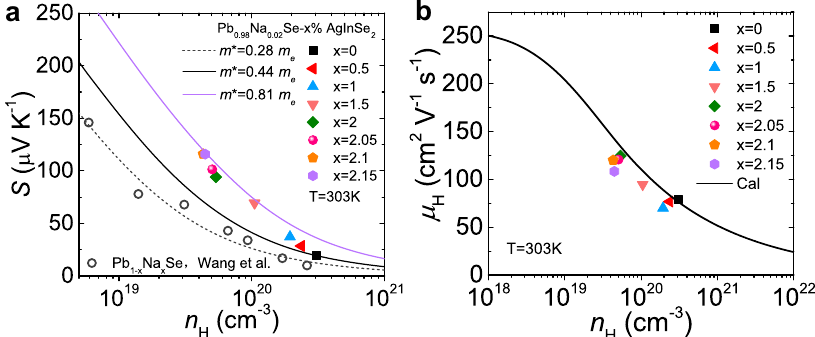
Fig. 4 Pisarenko plot and Hall carrier mobility. a Pisarenko plot of Seebeck coef fi cients as a function of Hall carrier concentration ( n H ) for Pb 0.98 Na 0.02 Se − x % AgInSe m * = 0.44 m m * = 0.81 m 2 (LISS). The solid black line is calculated assuming e and the purple line represents the result assuming e within the SPB model. The gray circles show the Pisarenko plot for Na-doped PbSe reported by Wang et al. 50 . b Hall carrier mobility ( μ H ) versus Hall carrier concentration ( n H ) at 303